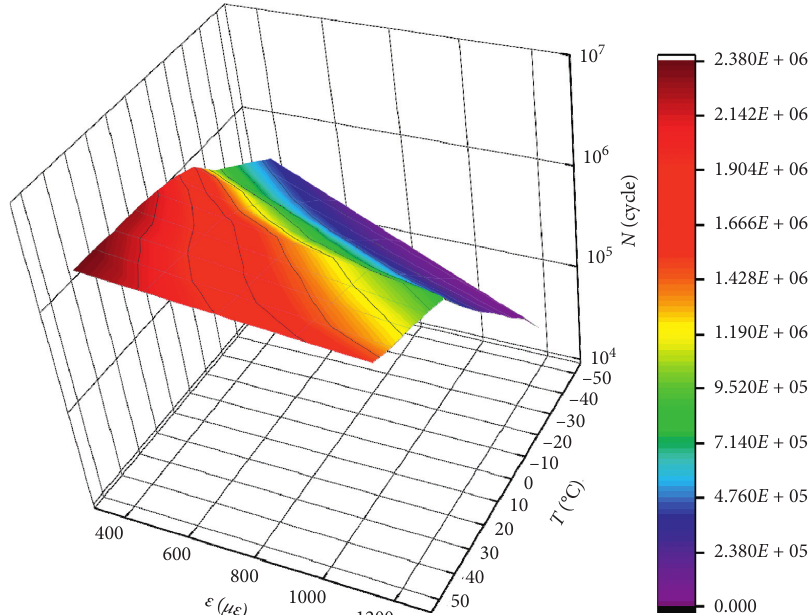
Figure 13: Fatigue life surface.